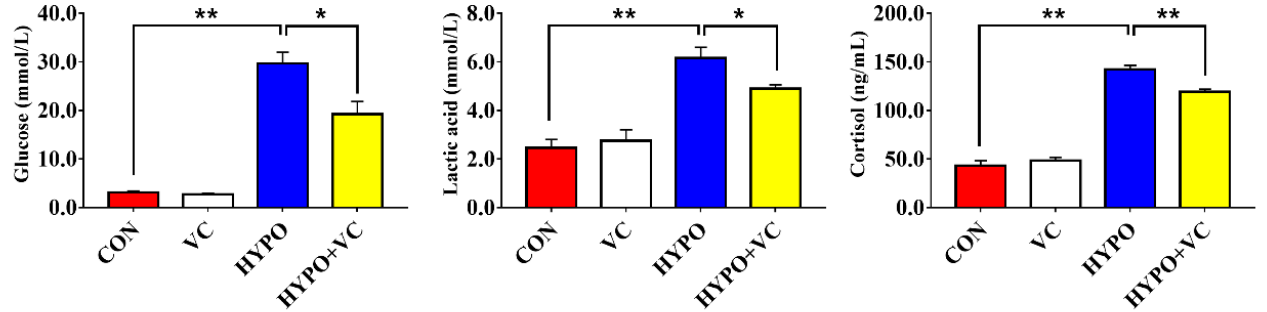
Figure 1. Plasma metabolites of gibel carp in the control and normal groups and hypoxia groups after feeding with VC for 56 days. The * or ** at the top of the bar chart indicates significant differences between treatments; * indicates a significant difference ( p < 0.05), and ** indicates an extremely significant difference ( p < 0.01). All of the data are presented as the mean ± standard error (n =